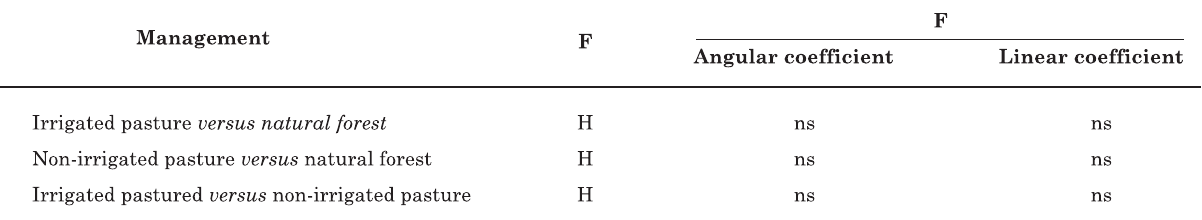
ns: non significant, F: test f, H: homogeneous.